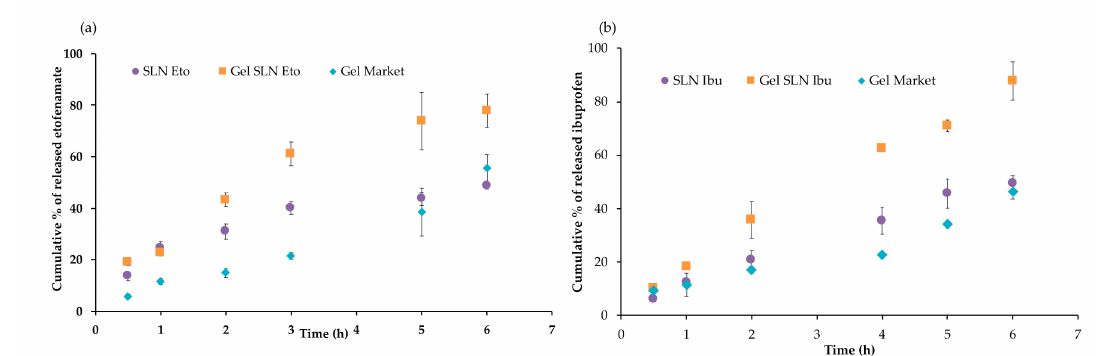
Figure 9. Release profiles of etofenamate ( a ) and ibuprofen ( b ) incorporated in SLN and SLN-gels, and commercial formulations (Gel Market) corresponding to Reumon ® Gel 5% (etofenamate) and Ozonol ® 5% (ibuprofen), through a Tuffryn ® membrane, after 6 h. Results are expressed as mean ± S.D.; n =